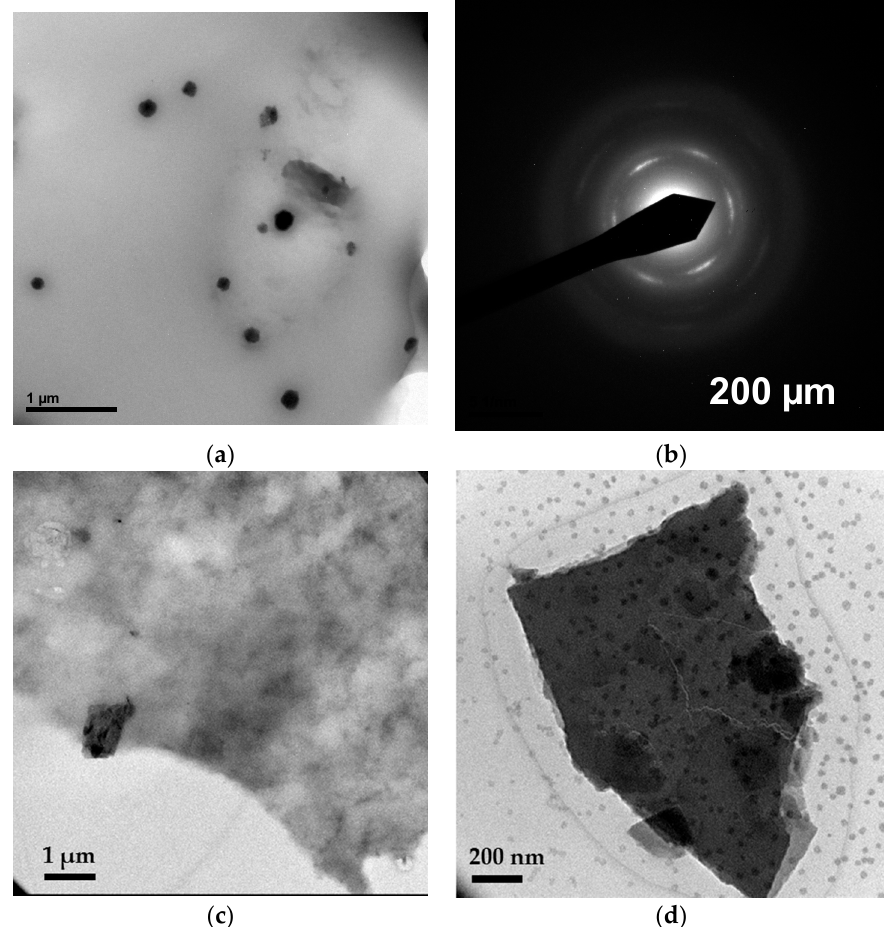
Figure 3. TEM images of MMM 5Cu/CS-PVA ( a ) and the electron diffraction to a single Cu NP ( b ); TEM images of 5CuAM-4/CS:PVA membrane ( c ) and a detail of 5CuUZAR-S3/CS:PVA membrane ( d ).